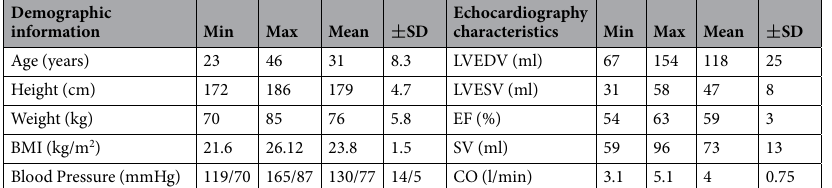
Demographic information